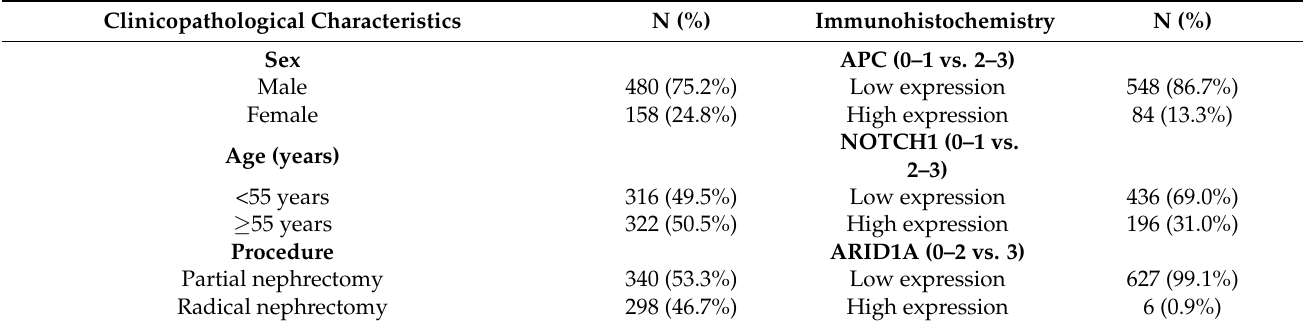
Table 1. Clinicopathological characteristics of the study population and immunohistochemistry results. Clinicopathological